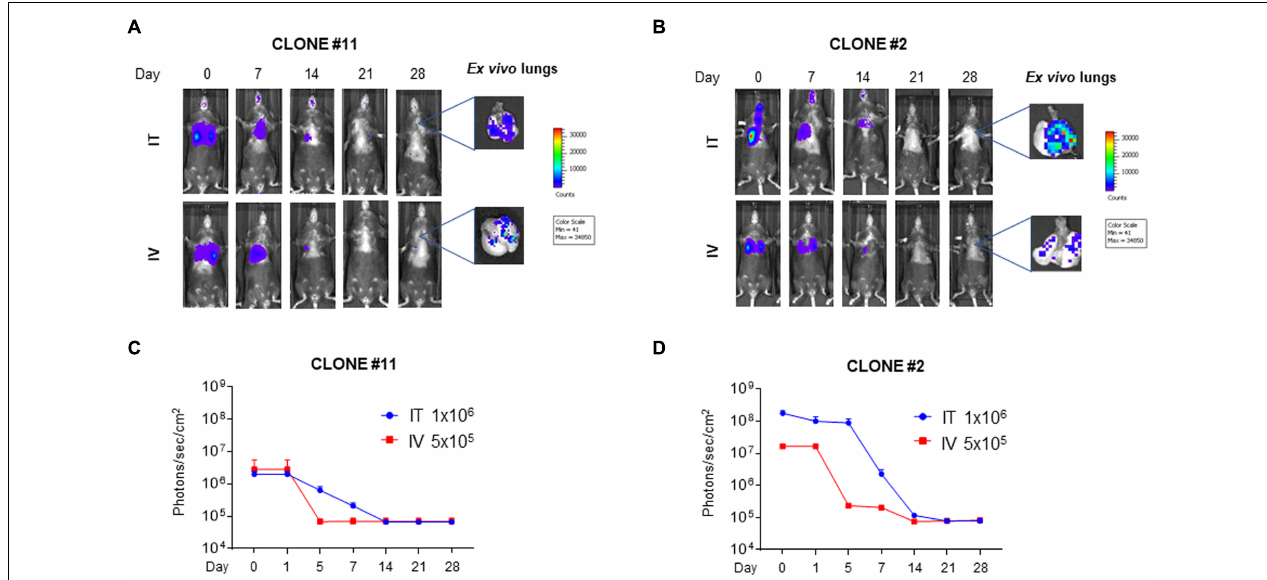
FIGURE 2 | In vivo and ex vivo imaging of mouse bone marrow-derived mesenchymal stromal/stem cells (mBM-MSCs) in mouse lung. (A,B) In vivo bioluminescence imaging (BLI) of four groups of mice ( n = 5 each) intratracheally (IT) and intravenously (IV) inoculated with mBM-MSCs clone #2 and #11 ( B,A , respectively). Mice were weekly monitored up to 4 weeks post inoculation. At each time point, mice were intraperitoneally (IP) injected with 200 µ l/mouse luciferin substrate to allow longitudinal detection of in vivo BLI. On day 28, mice were anesthetized and lungs were harvested for ex vivo imaging using In Vivo Imaging System (IVIS) BLI system. (C,D) BLI signal from mouse chest of each group was quantified seven times, expressed as photons/s/cm 2 and plotted as mean ± standard error of the mean (SEM) using the software Living Image R (cid:13) version 4.3.1. BLI signal at each time point represents the mean ± standard deviation of five animals. No significant differences were detected between IT and IV groups for either clone #11 or clone #2 ( p > 0.05, two-way ANOVA test followed by Sidak’s test for multiple